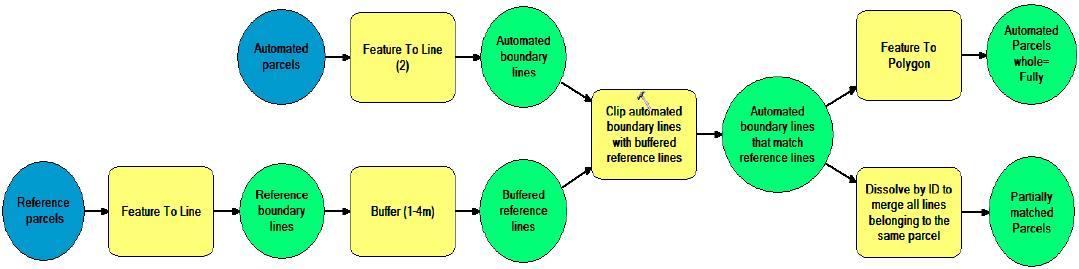
Figure 5. Model for assessing edge error between reference and automated boundary lines.